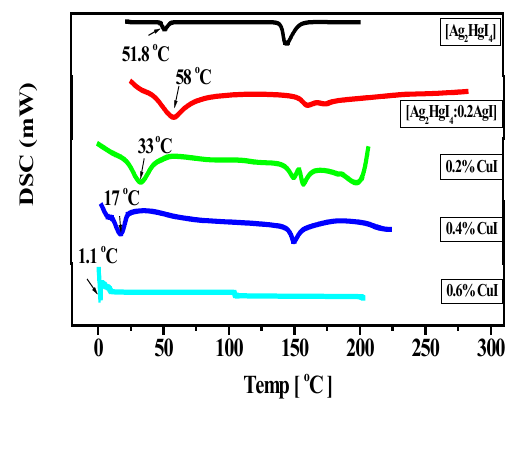
Figure 6. Differential scanning calorimetry (DSC) curves for mixed composite systems [Ag amount of CuI.